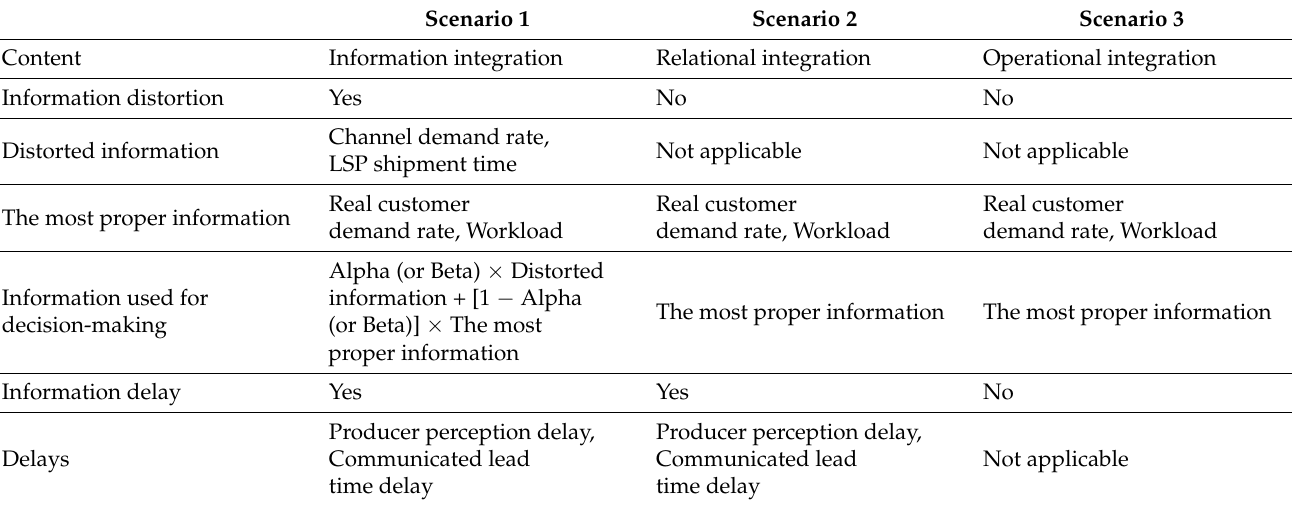
Table 2. Illustration of structure